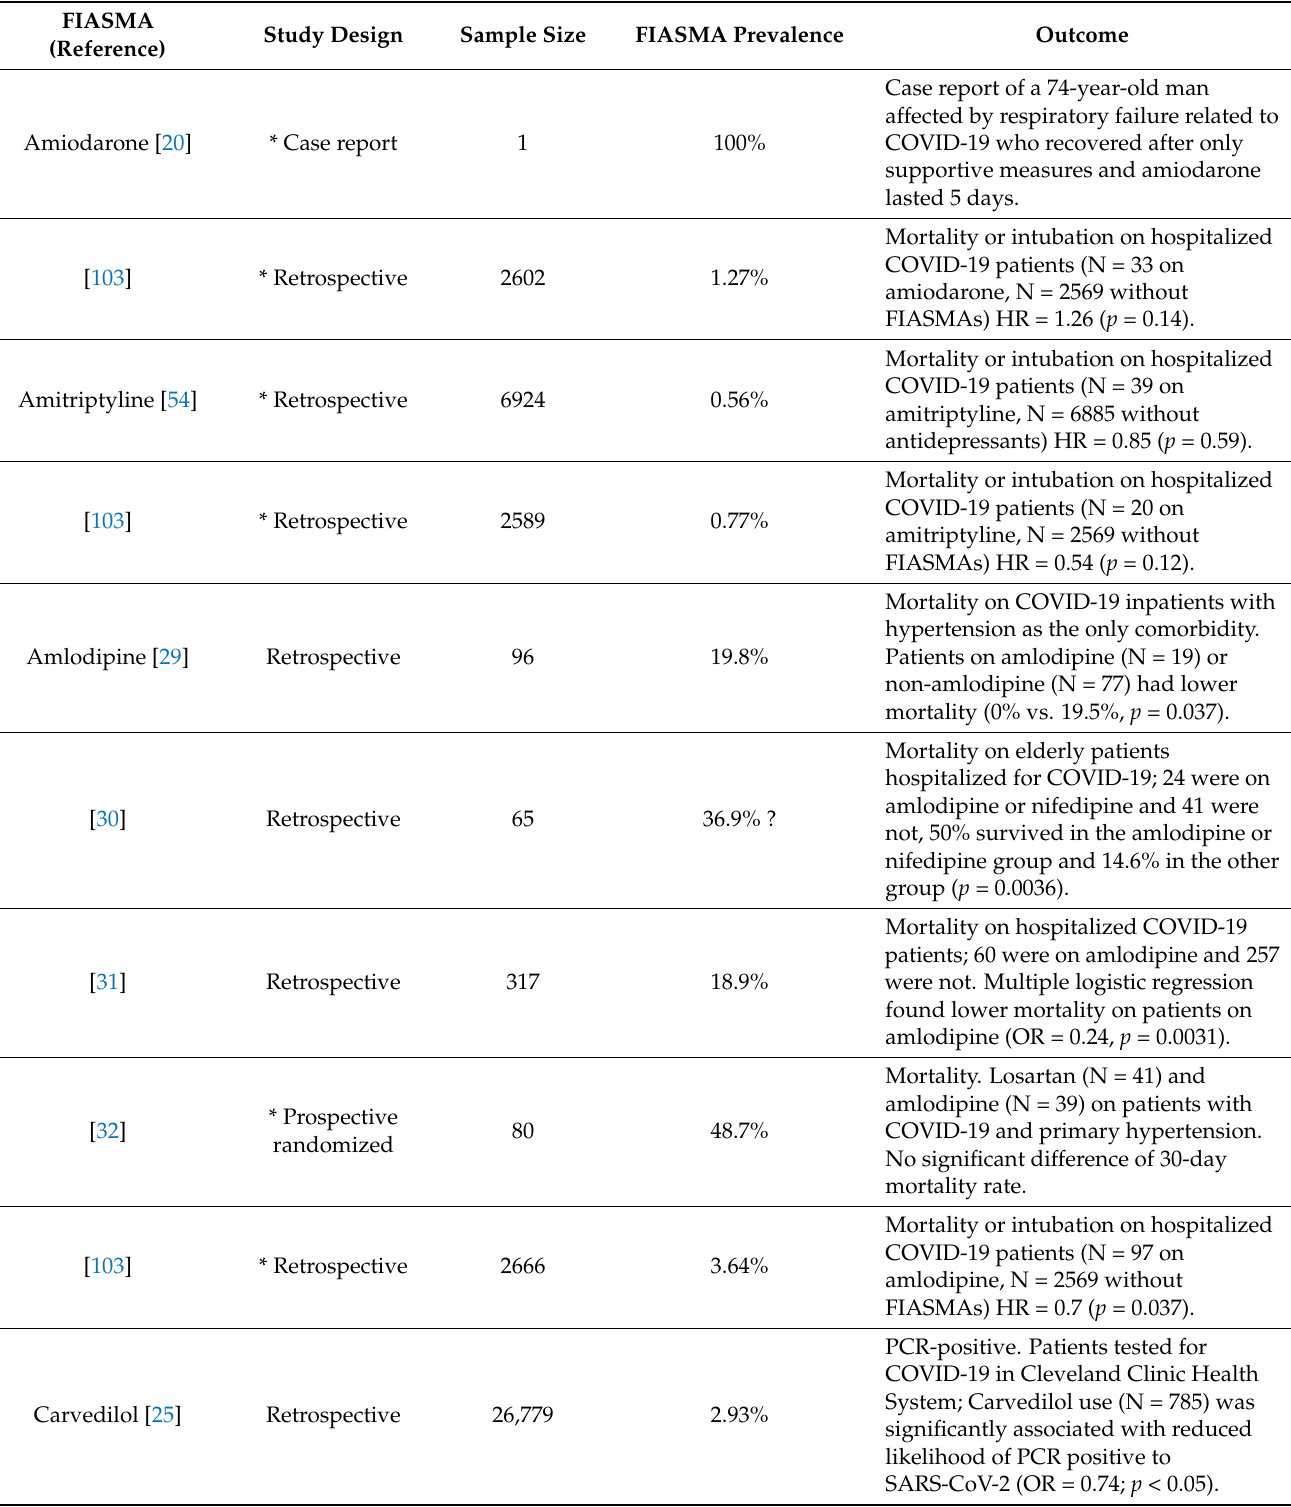
Table 2. Functional inhibitors of acid sphingomyelinase (FIASMAs) (N = 15) with activity against SARS-CoV-2 in epidemio- logical, clinical studies, or case